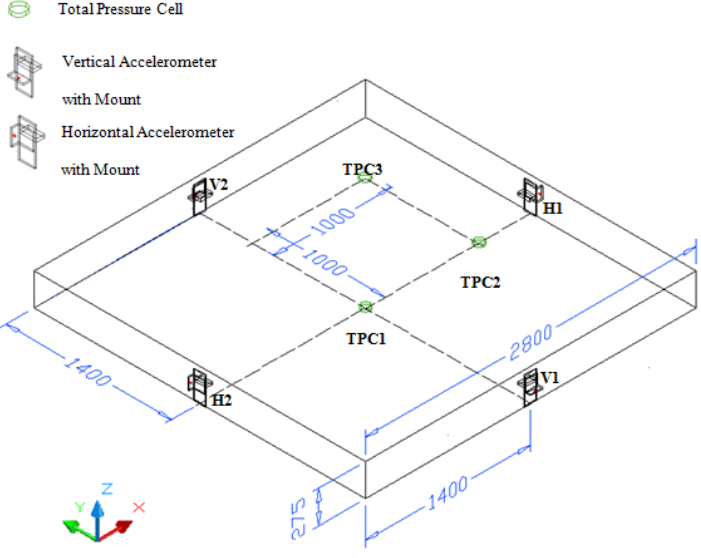
Figure 9. Layout of instrumentation for field blast test. TPC, total pressure cell.